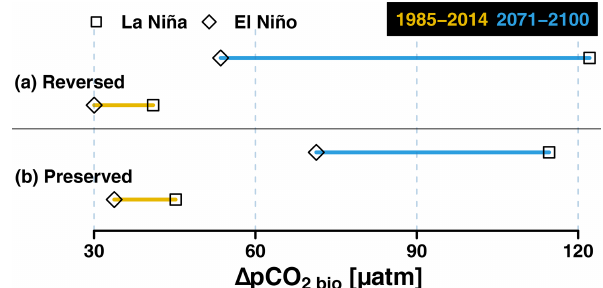
Figure 8. Multi-model mean average biological contribution to the oceanic p CO 2 (in µatm) deficit during La Niña and El Niño regimes for the 1985–2014 and 2071–2100 period for all reversed (a) and preserved (b) models in the EP